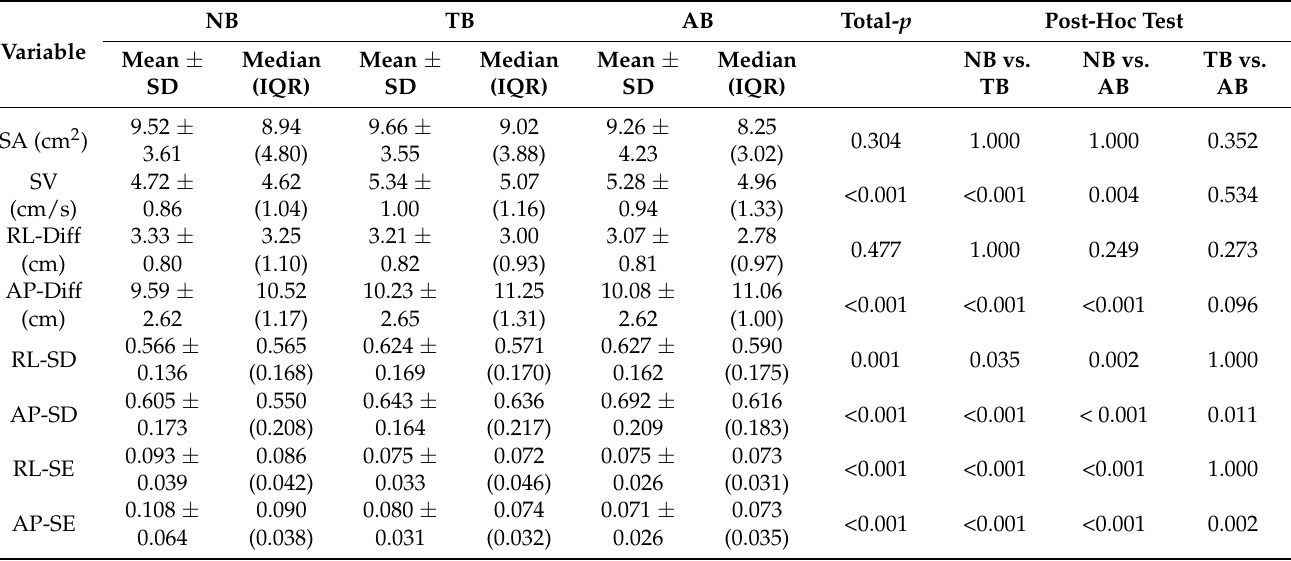
Table 5. Balance ability in single-leg